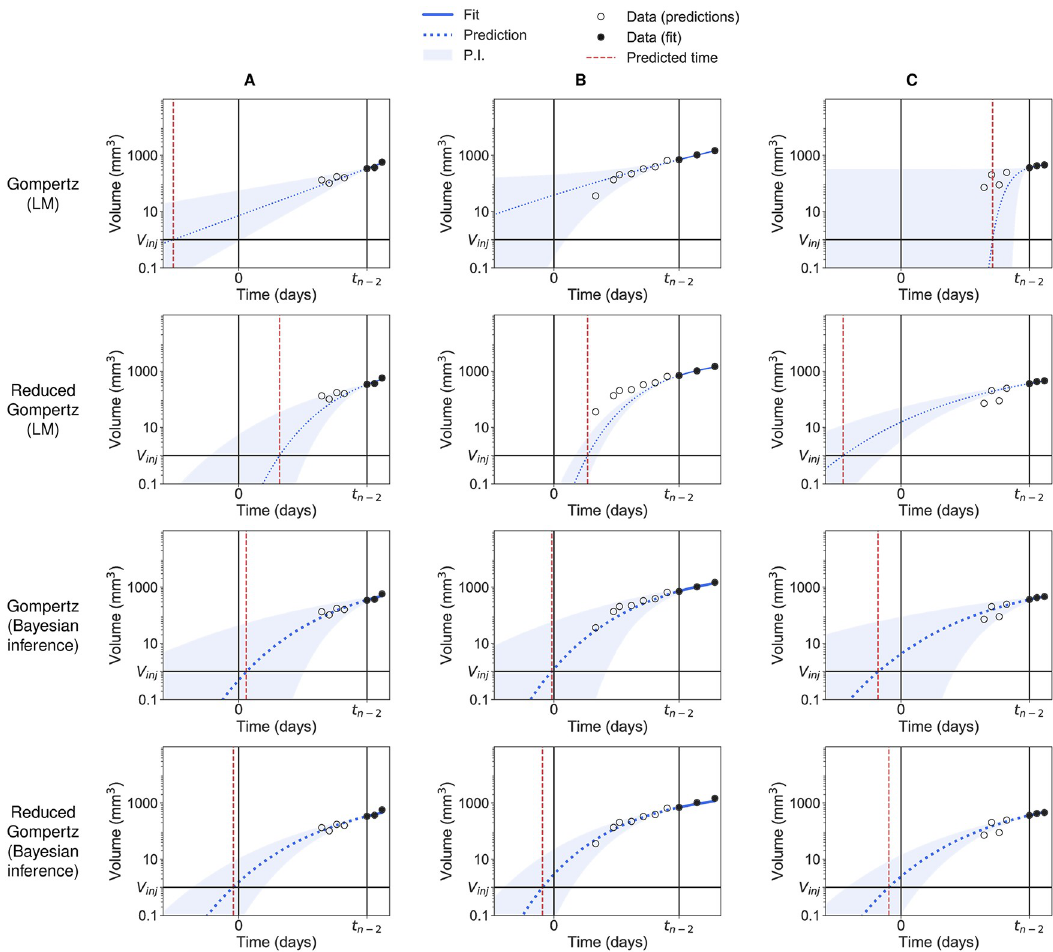
Fig 4. Backward predictions computed with likelihood maximization and with Bayesian inference. Examples of backward predictions of three individuals (A), (B) and (C) computed with likelihood maximization (LM) and Bayesian inference: Gompertz model with likelihood maximization (first row); reduced Gompertz with likelihood maximization (second row); Gompertz with Bayesian inference (third row) and reduced Gompertz with Bayesian inference (fourth row). Only the last three points are considered to estimate the parameters. The grey area is the 95% prediction interval (P.I) and the dotted blue line is the median of the posterior predictive distribution. The red line is the predicted initiation time and the black vertical line the actual initiation